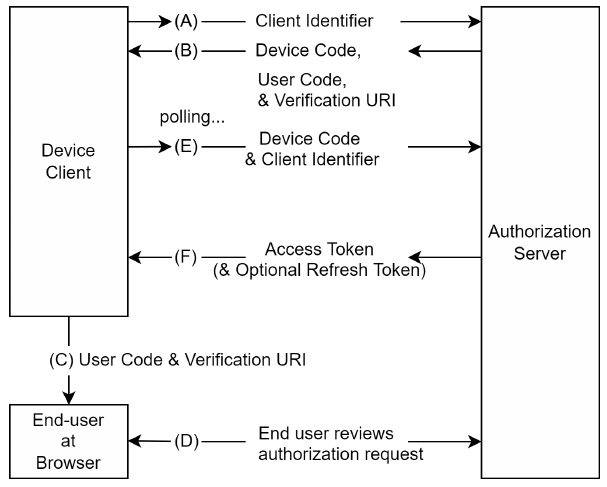
Figure 3. OAuth Device Authorization Flow